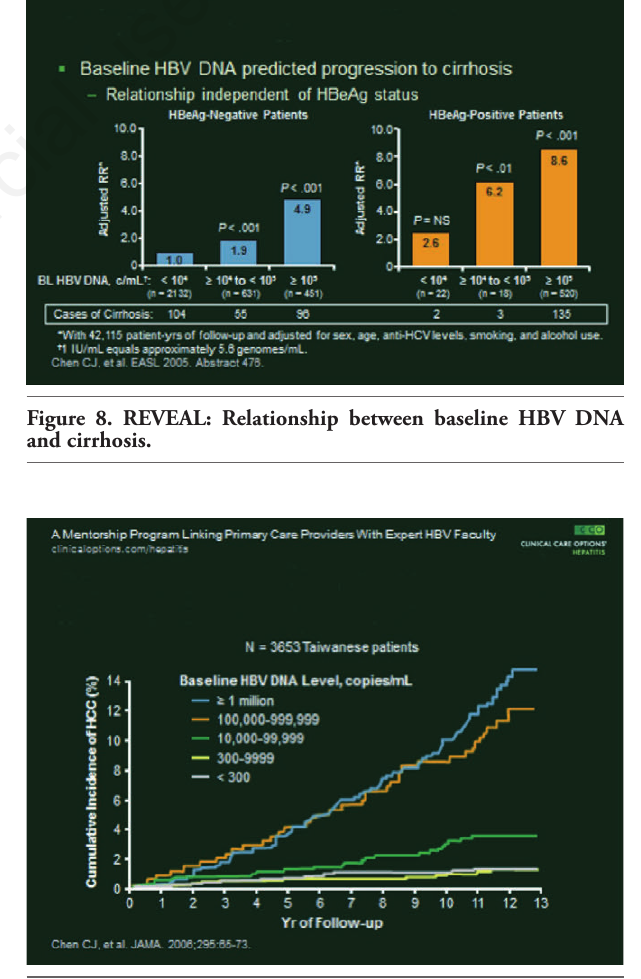
Figure 6. Phases of chronic HBV infection.